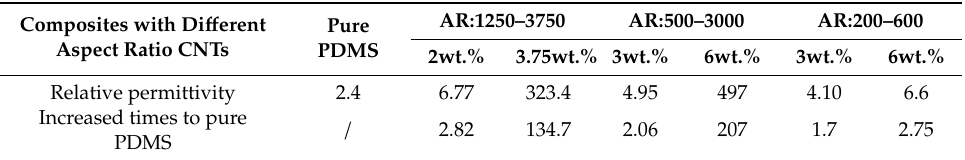
Figure 3. The relative permittivities of the CNTs / PDMS composites versus the CNTs mass fractions. Table 2. The relative permittivities of the CNTs/ PDMS composites with different aspect ratios CNTs as filler at certain mass fraction.